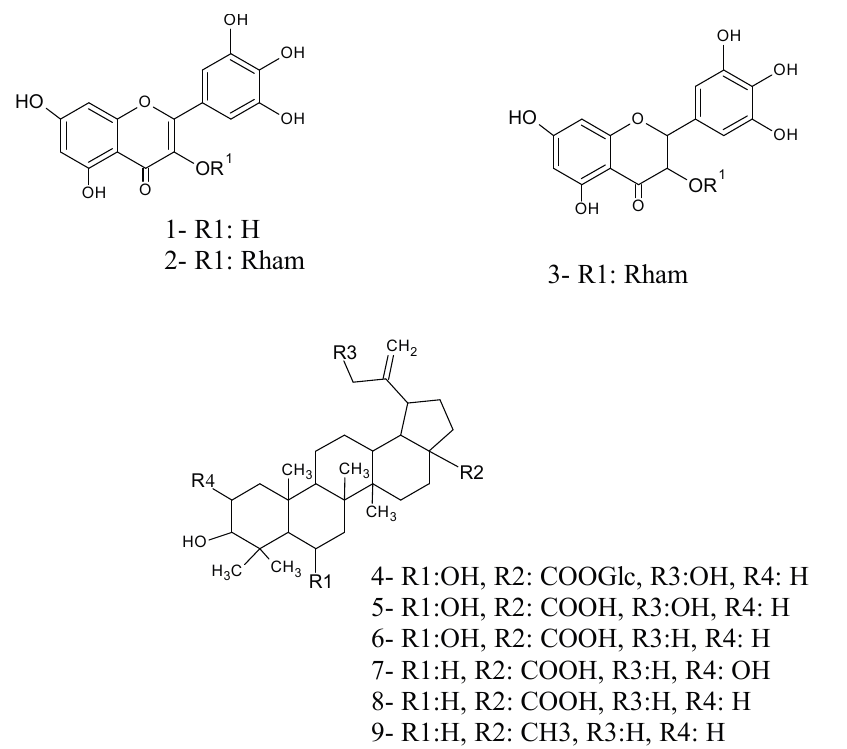
Figure 1. Structures of isolated compounds from Licania cruegeriana